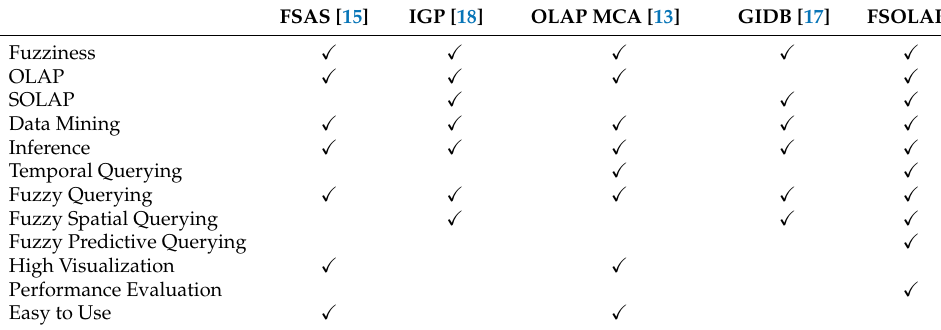
Table 8. Comparision of FSOLAP and existing